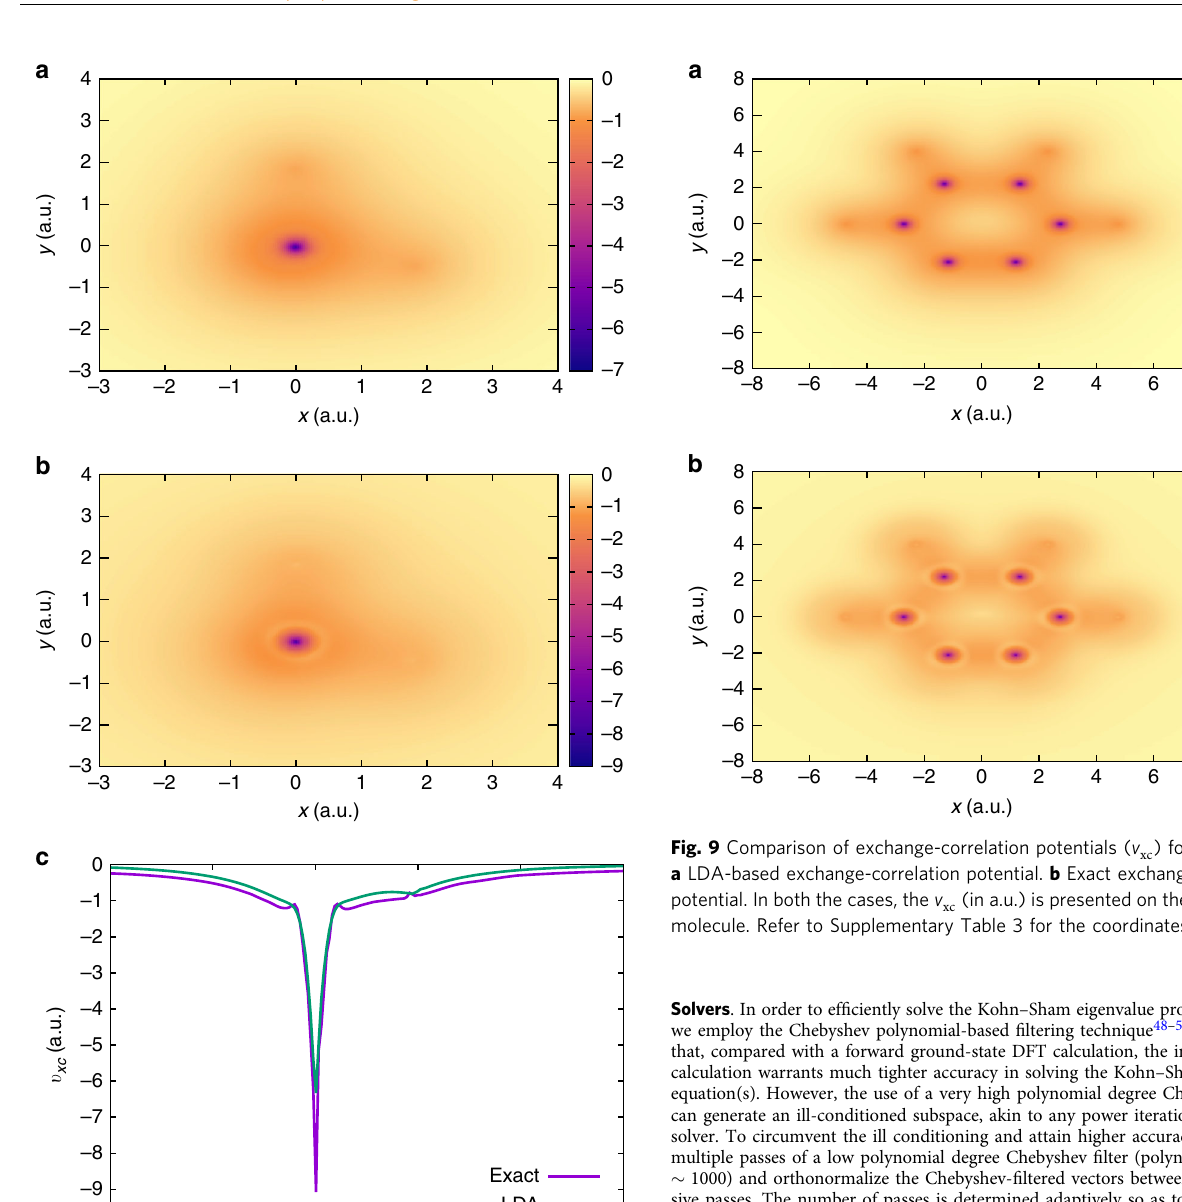
Fig. 8 Comparison of exchange-correlation potentials ( v a LDA-based exchange-correlation potential. b Exact exchange-correlation potential. c Comparison of the LDA-based and the exact exchange- correlation potential along the O – H bond. In a and b , the v presented on the plane of the molecule. Refer to Supplementary Table 3 for the coordinates